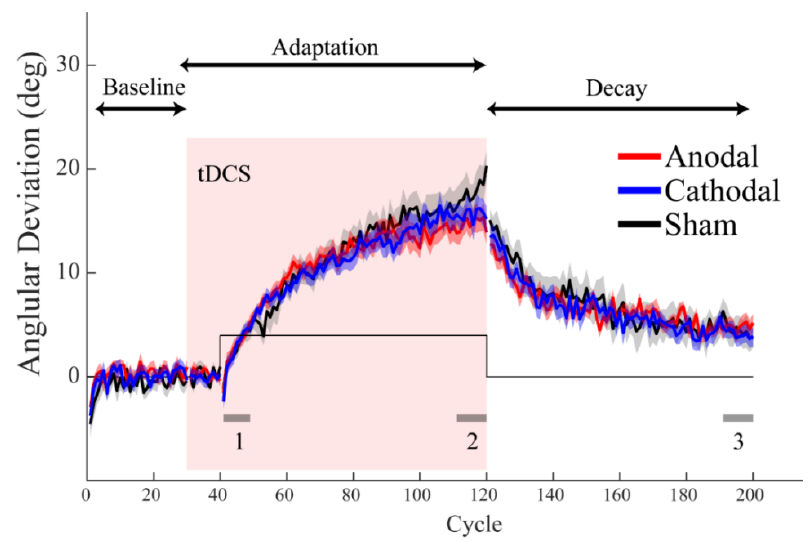
Figure 3. Adaptation performance in Experiment 2. The angular deviation as a function of trial cycles. The group average (line) and standard error (shade) across participants are shown. The anodal, cathodal, and sham groups are plotted in red, blue, and grey, respectively. Only the baseline, adaptation, and decay phases within a day were collected and marked by arrows on top of the figure. The red rectangular area denotes the duration of ctDCS application. The solid black line denotes the rotation perturbation. The grey segments on the bottom of the figure show the windows for calculating performance measures: 1 to 3 are for adaptation rate, adaptation extent, and decay residue,